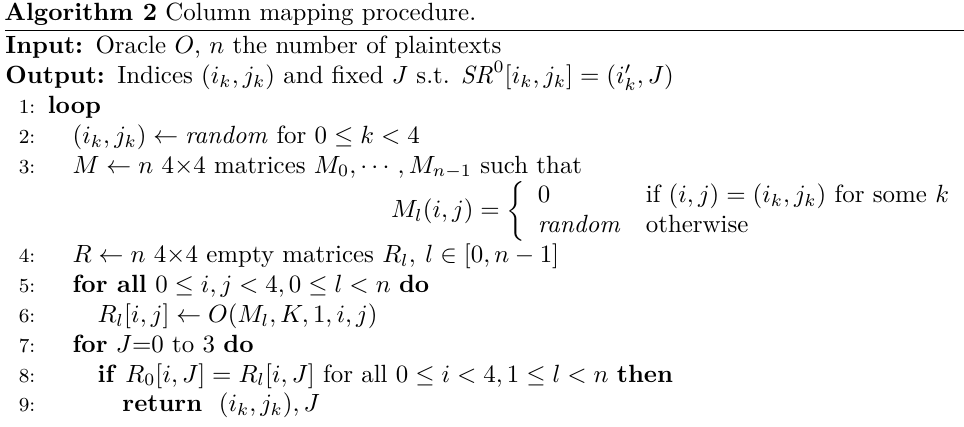
Algorithm 2 Column mapping procedure.